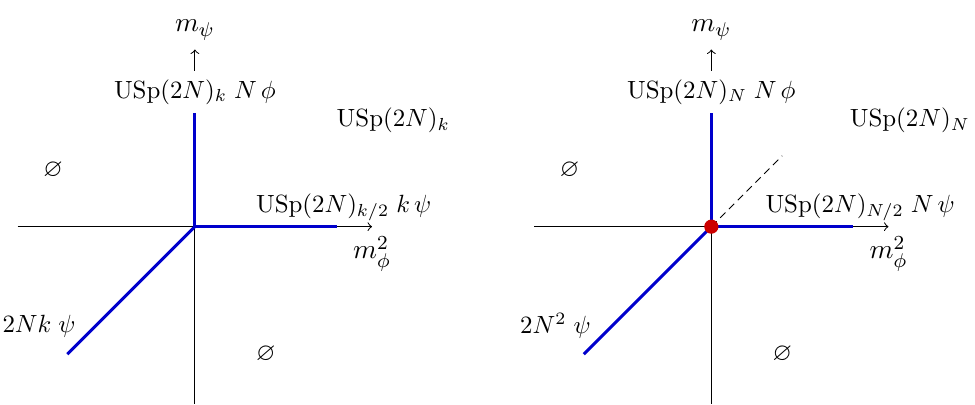
Figure 6 . (Left) Phase diagram of USp(2 N ) k with N φ , k ψ . We have not indicated gravitational 2 couplings for simplicity. The symbol ∅ indicates a gapped state with no topological order. (Right) Phase diagram specialized to the case N = k . In this case there is emergent time-reversal symmetry (with an anomaly) along the dashed line. We conjecture that there exists a time-reversal invariant tri-critical fixed point at the